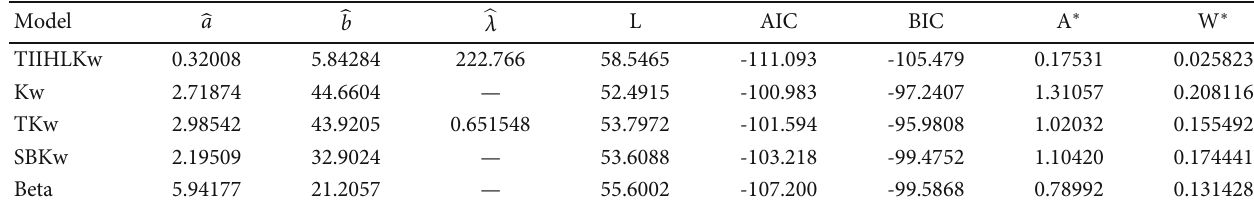
Table 8: MLEs and goodness-of- fi t measures for the second data set.